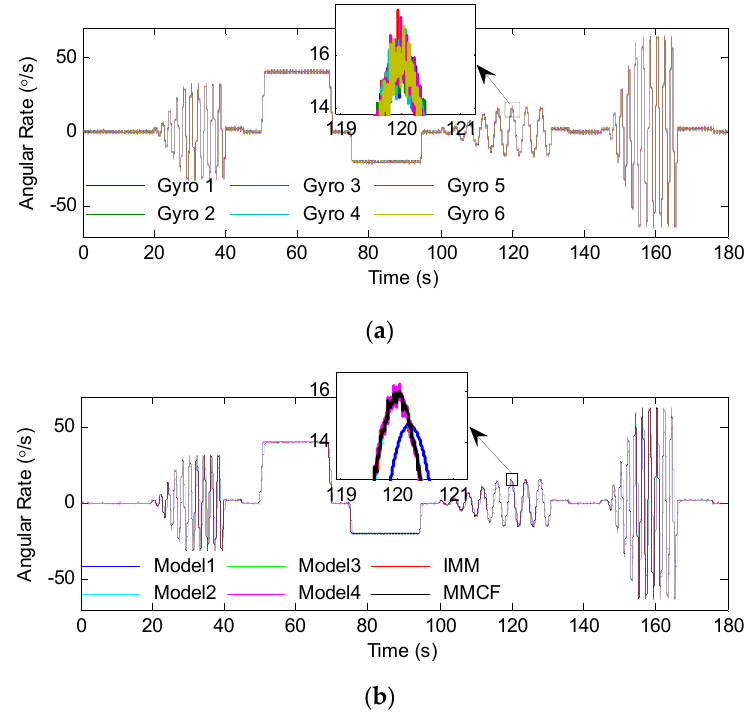
Figure 9. The overall experiment outputs: ( a ) The outputs of individual gyroscopes; ( b ) the angular rate of the gyro array estimated by using different methods.